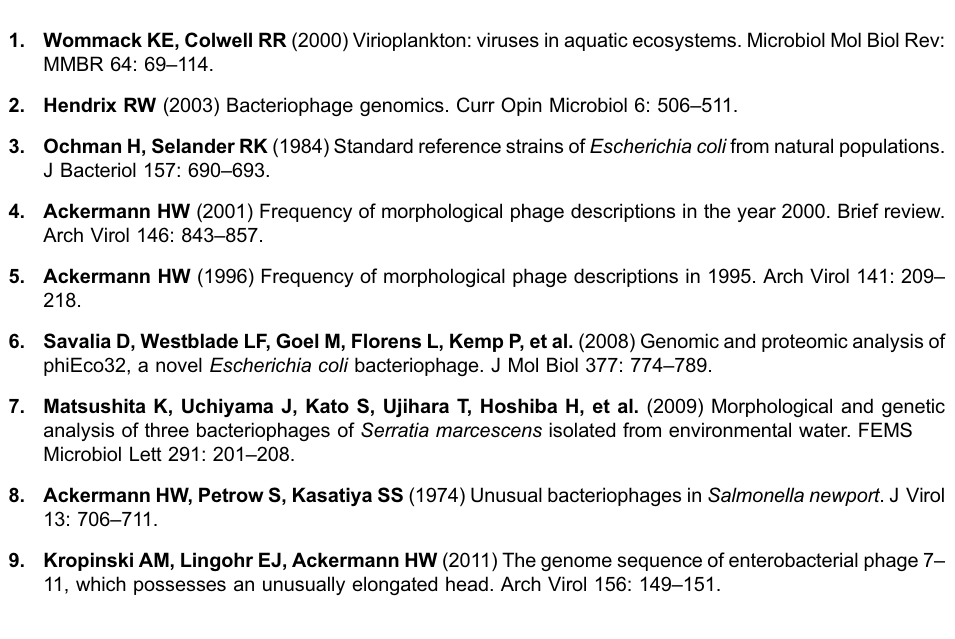
S1 Fig. Protein secondary structure predictions of the N-terminal end of scaffolding proteins inferred from C3 morphotype phage genomes (1–5) and phages with C1 morphotype genomes (6–9). S1 Table. Proteins inferred from the SU10 genome sequence and results of BLASTP searches for similar proteins in other phages with C3 morphotype. S2 Table. Early and middle transcription promoter and terminator sequences and their location in the genome of